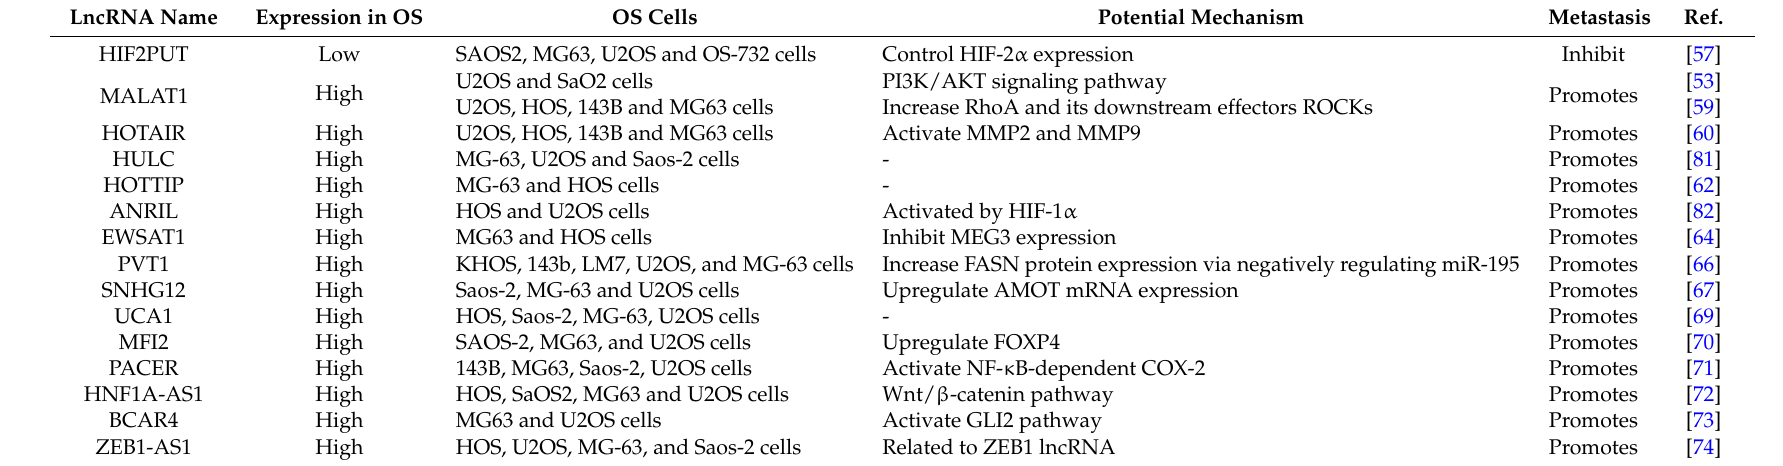
Table 2. Long non-coding RNAs associated with metastasis of